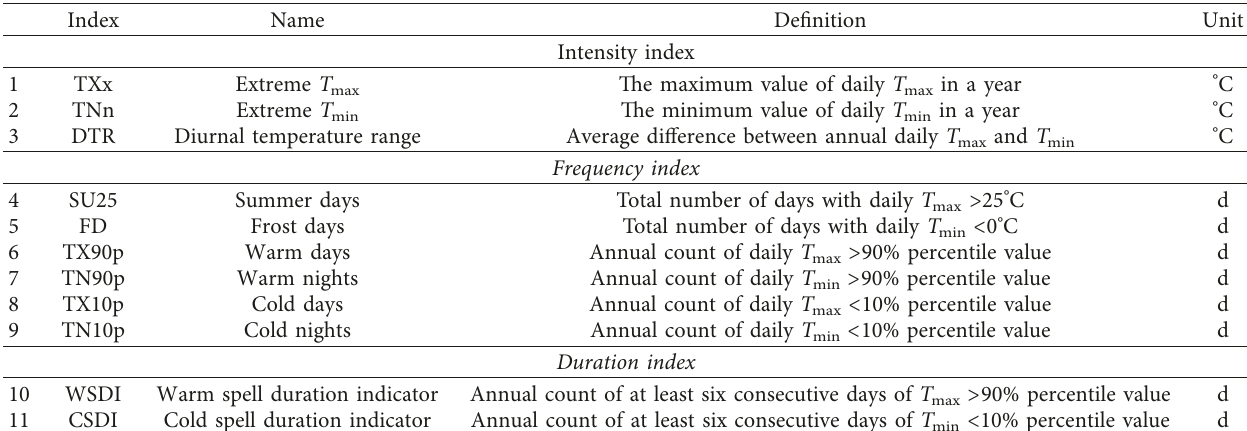
Table 1: Definition of extreme temperature